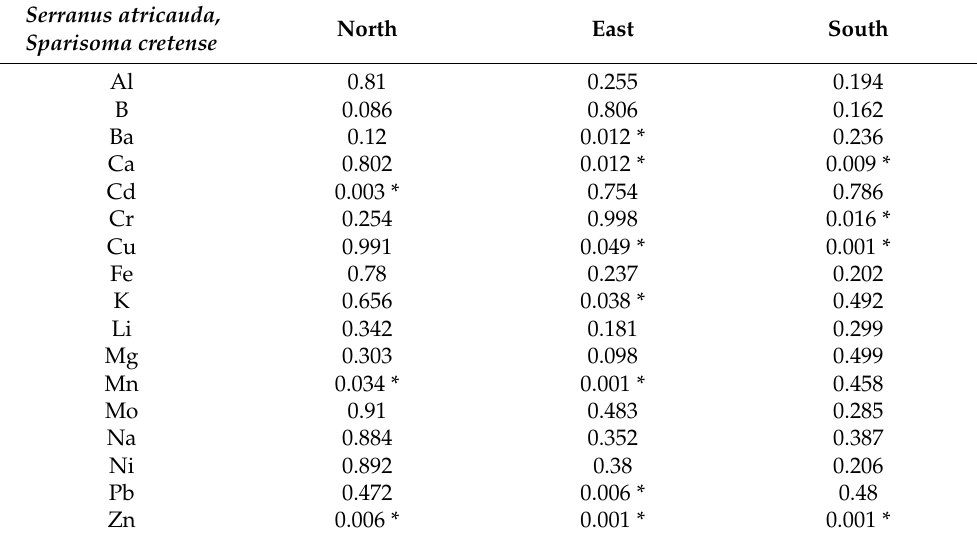
Table 5. Results of pairwise tests examining the significant factor of ‘Zones’ obtained in the two-way PERMANOVA analyzing the variation in the content of heavy metals and trace elements in muscle tissue in species according to study zone, considering the level of the factor “Zones”. Serranus atricauda, North East Sparisoma cretense